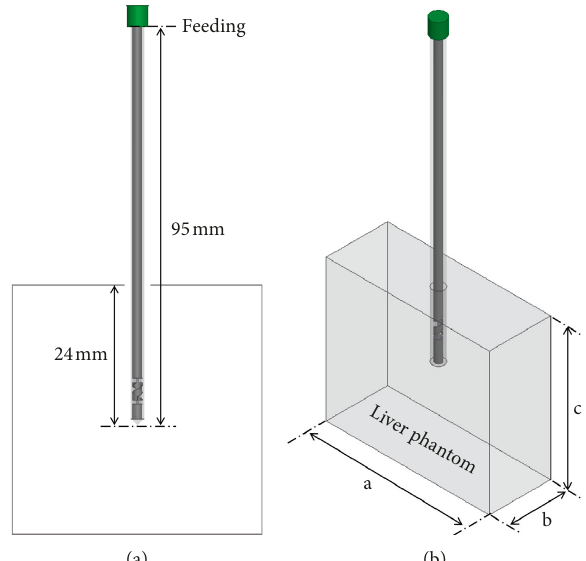
Figure 2: (a) Total view of the inserted antenna and dimensions of length and depth. (b) The view of the inserted antenna into the liver phantom.